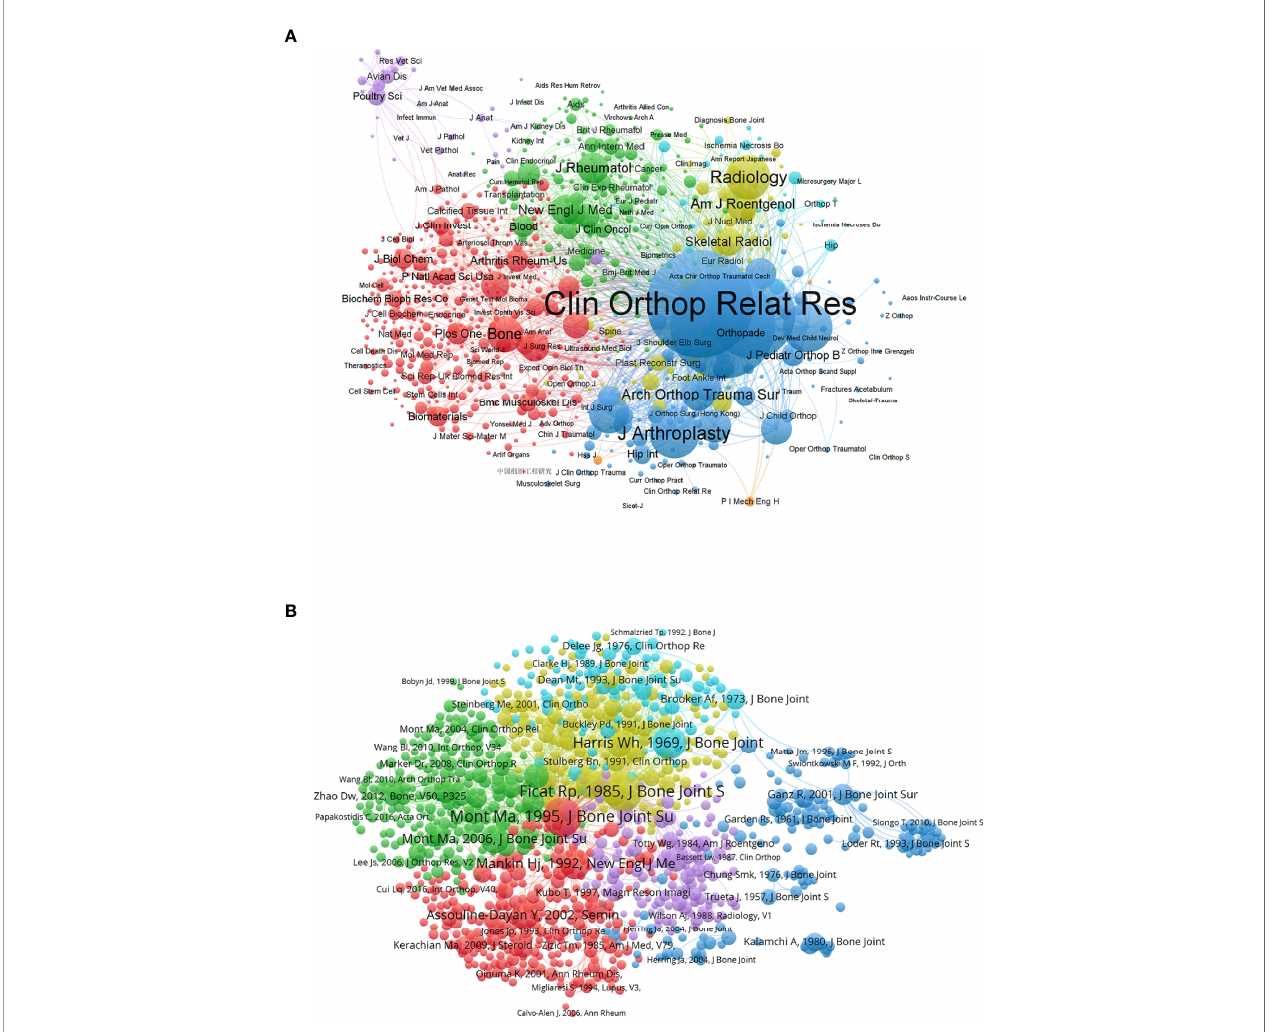
FIGURE 7 | Co-citation analysis of global publications in ONFH in the last 30 years. (A) Network visualization of the 841 identi fi ed journals in ONFH. (B) Network visualization of the 1,184 identi fi ed publications in ONFH. In the visualized network, each item is represented by a circle. The size of the circle is determined by the number of publications of the item. The distance between two circles approximately indicates the relatedness of the items. Item color is determined by the cluster to which the item